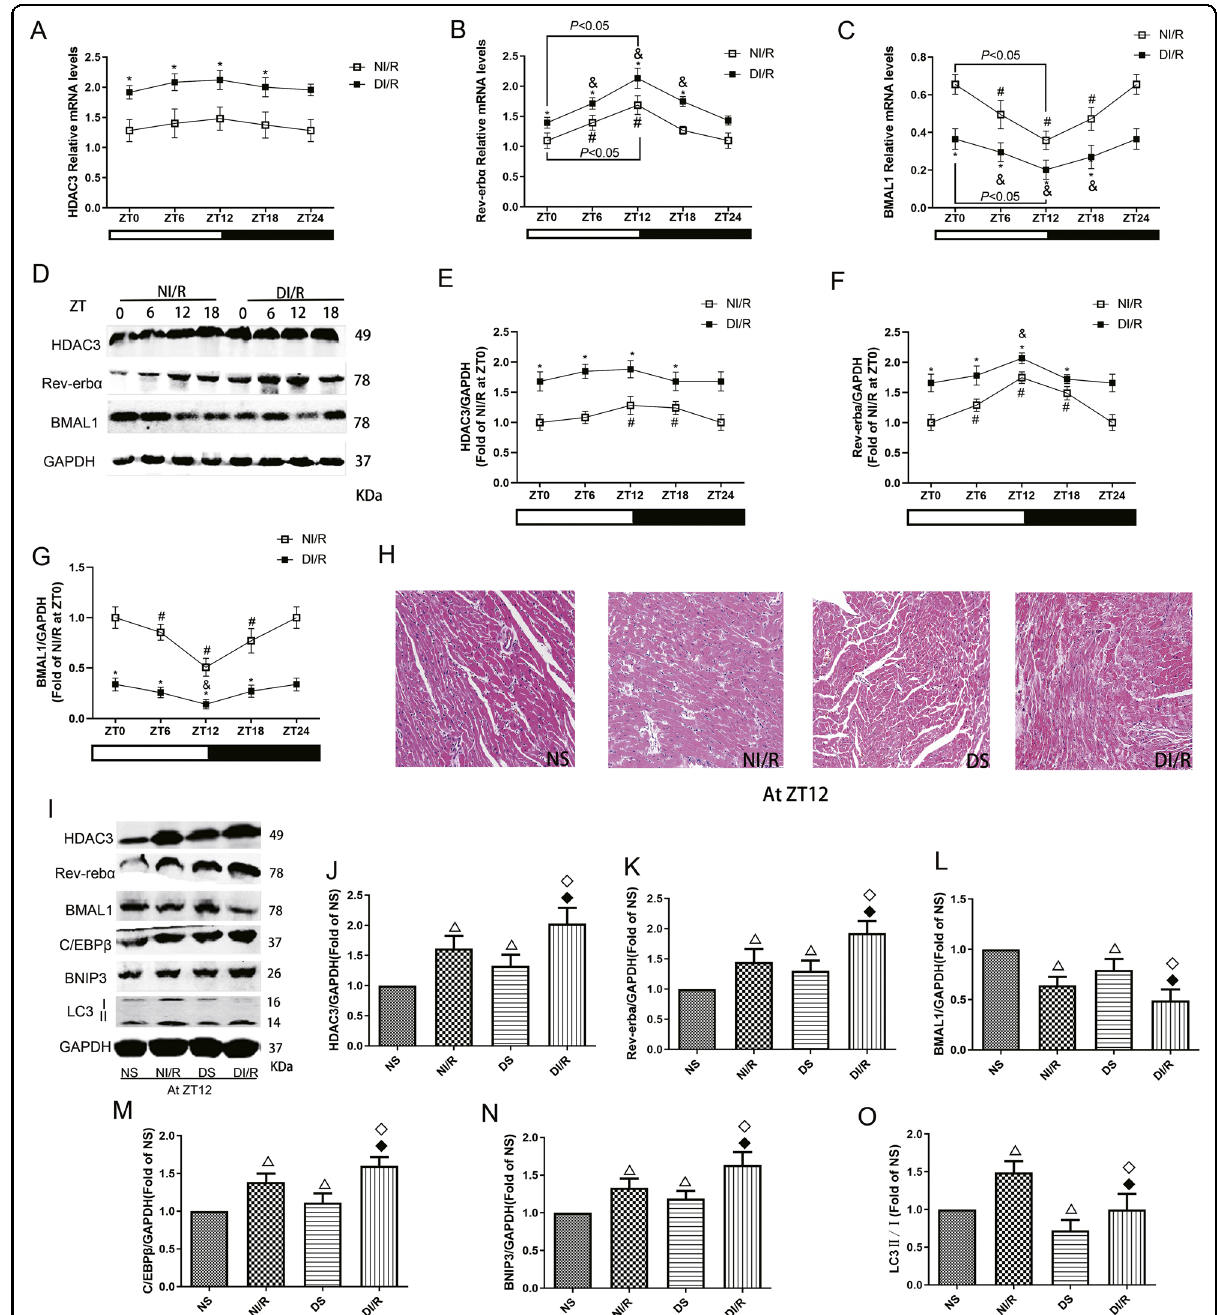
Fig. 3 The increased vulnerability to MI/RI in diabetes is associated with HDAC3 mediated disruption of circadian gene expression oscillations by inhibiting mitophagy. A – C The mRNA levels of HDAC3 ( A ), Rev-erb α ( B ), and BMAL1 ( C ) were analysed by qPCR. D – G The protein levels of HDAC3 ( E ), Rev-erb α ( F ), and BMAL1 ( G ) were analysed by western blotting in myocardial tissues of non-diabetic and diabetic rats with I/R insult. H HE staining of hearts from NS, NI/R, DS, or DI/R mice at ZT12. Scale bar: 100 μ m. I – O The protein levels of HDAC3 ( J ), Rev-erb α ( K ), BMAL1 ( L ), C/EBP β ( M ), BNIP3 ( N ) and LC3 II/I ( O ) in NS, NI/R, DS or DI/R group at ZT12 were detected by western blotting. n = 6 per group. * P < 0.05 versus NI/R within ZT; # P < 0.05 versus ZT0 within NI/R; & P < 0.05 versus ZT0 within DI/R; △ P < 0.05 versus NS; ◇ P < 0.05 versus DS; ◆ P < 0.05 versus